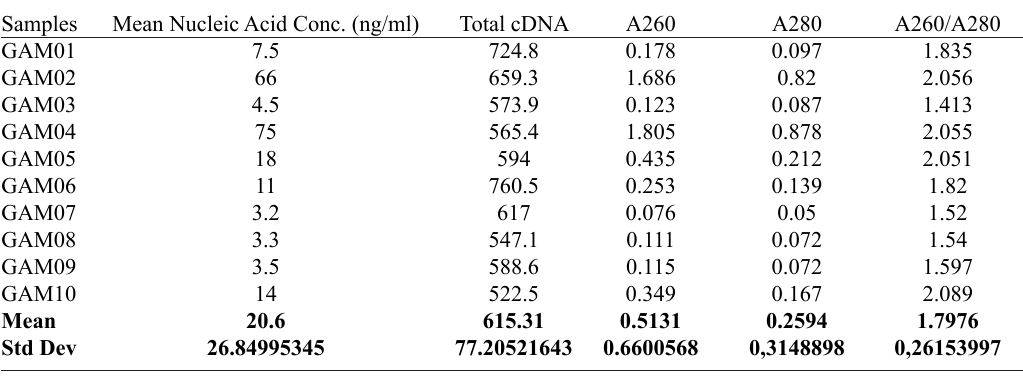
Table 1. Quantification of total RNA, cDNA and spectophotometry from heart